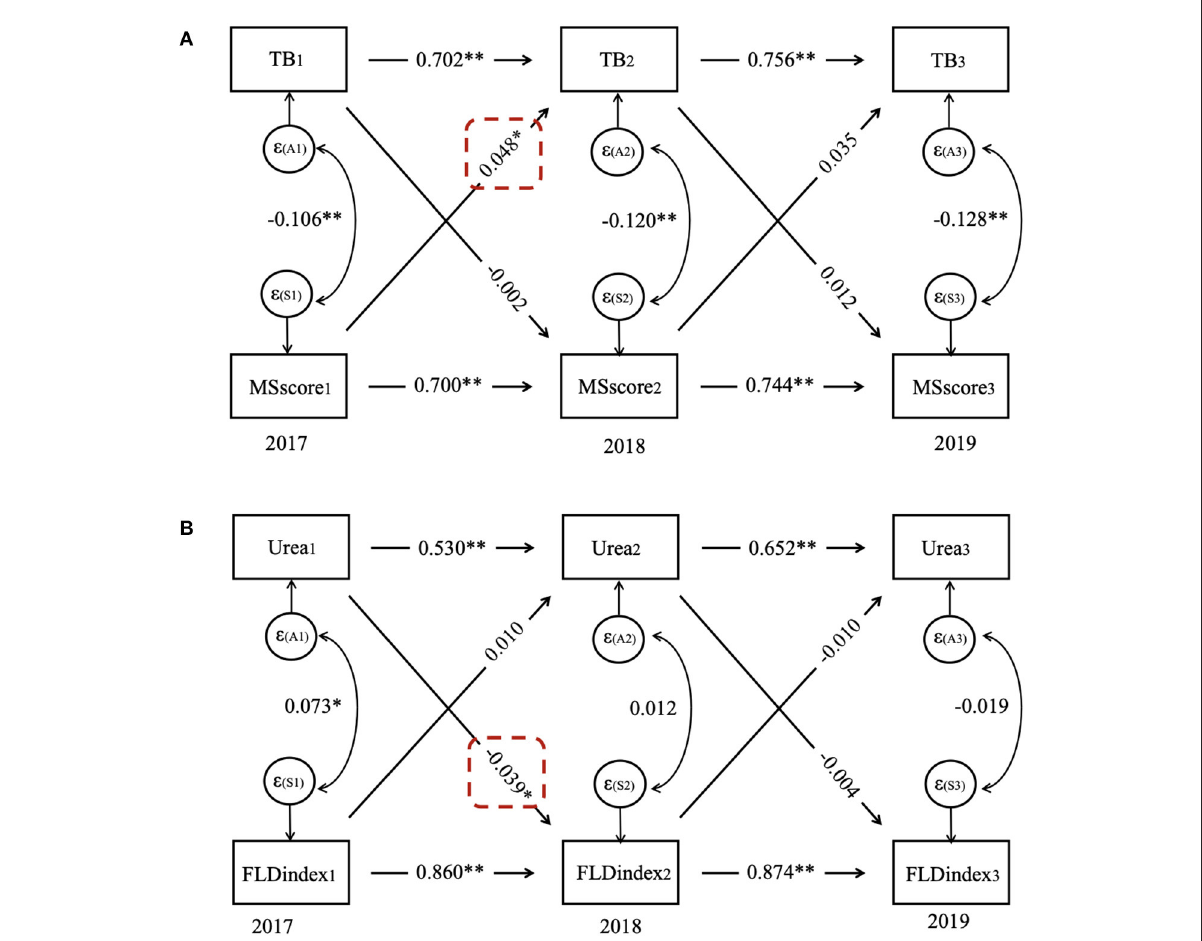
FIGURE5 Cross-lagged panel model for (A) TB and MS score in females and (B) urea and FLD index in males. FLD index, fatty liver disease index; MS score, metabolic syndrome score; TB, total bilirubin.